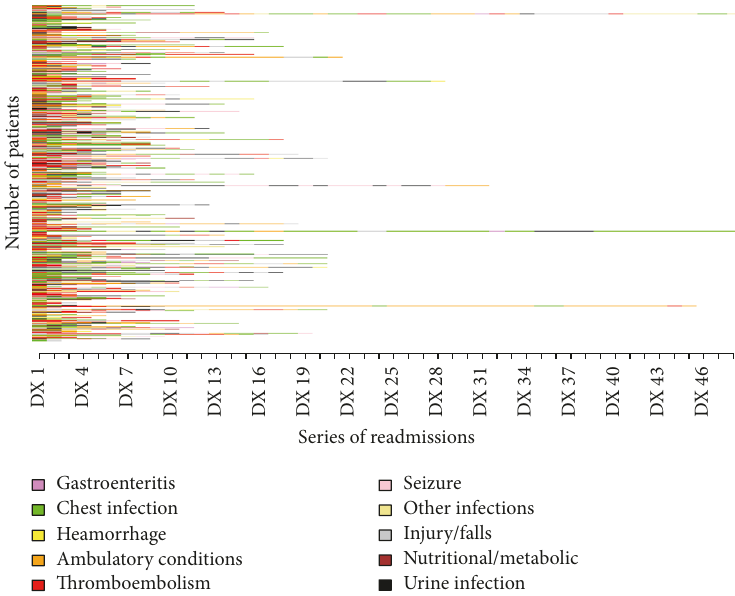
Figure 2: Depiction of ischaemic stroke patients and their colour-coded sequences of readmissions.